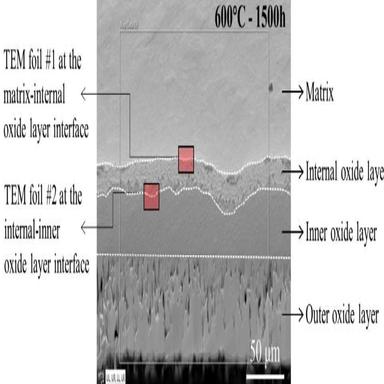
The locations of the TEM foils in the oxide of T91 after exposure in SCW at 600 °C for 1500 h.